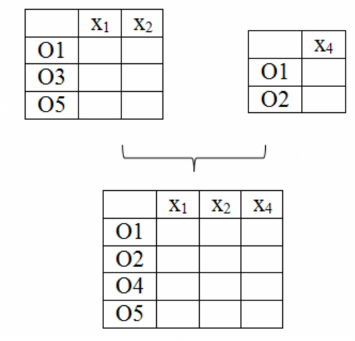
Figure 5. Merging of two candidate training